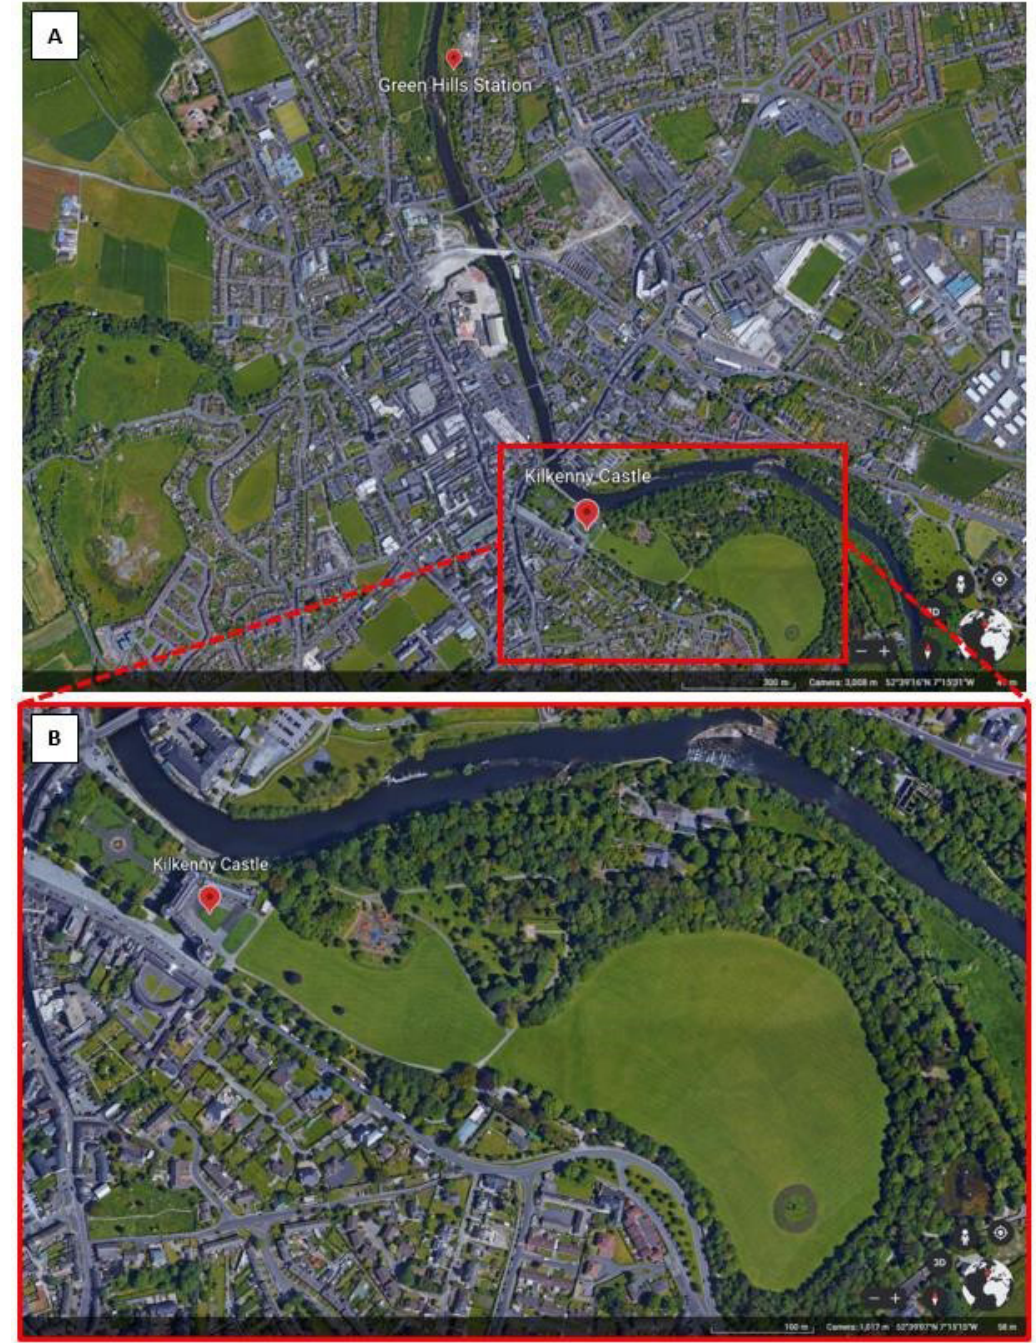
Figure 1. Aerial image of Kilkenny Castle and its’ surrounding area (a) and the grounds of the castle (b) (©Google Earth,